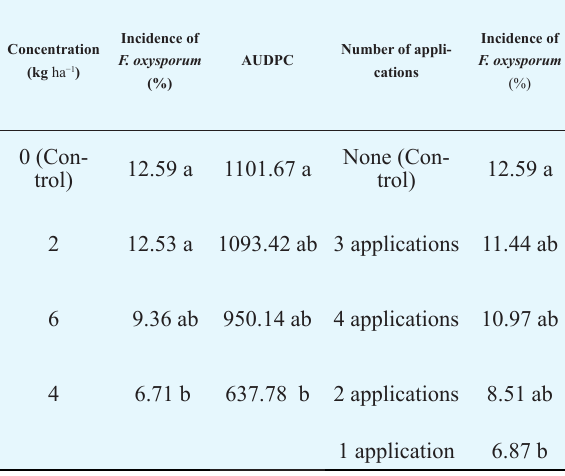
Incidence of F. oxysporum